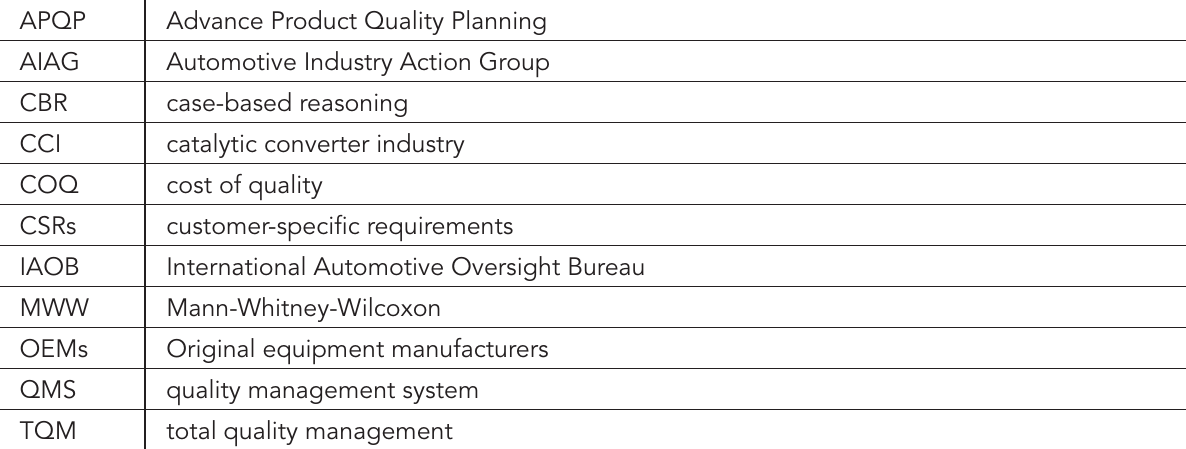
Table of acronyms and